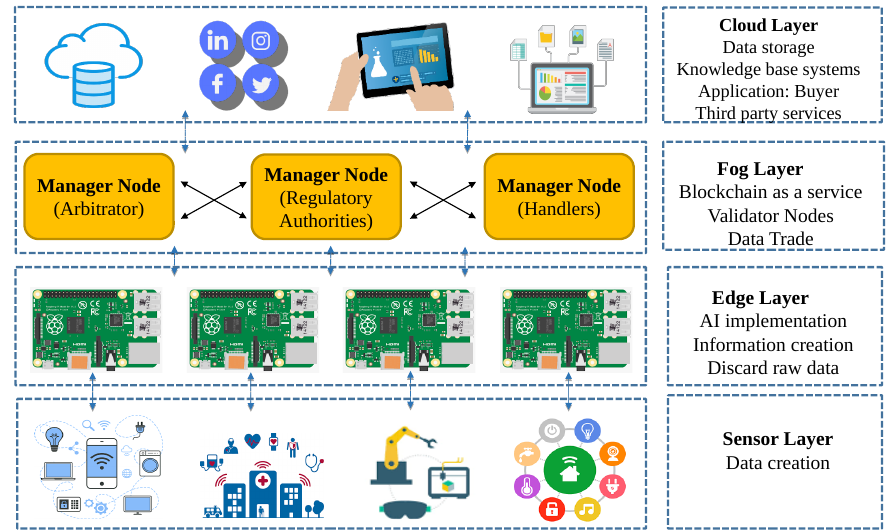
Figure 1. Architecture of EdgeBoT, a distributed P2P data trade and fair access network model based on the ethereum